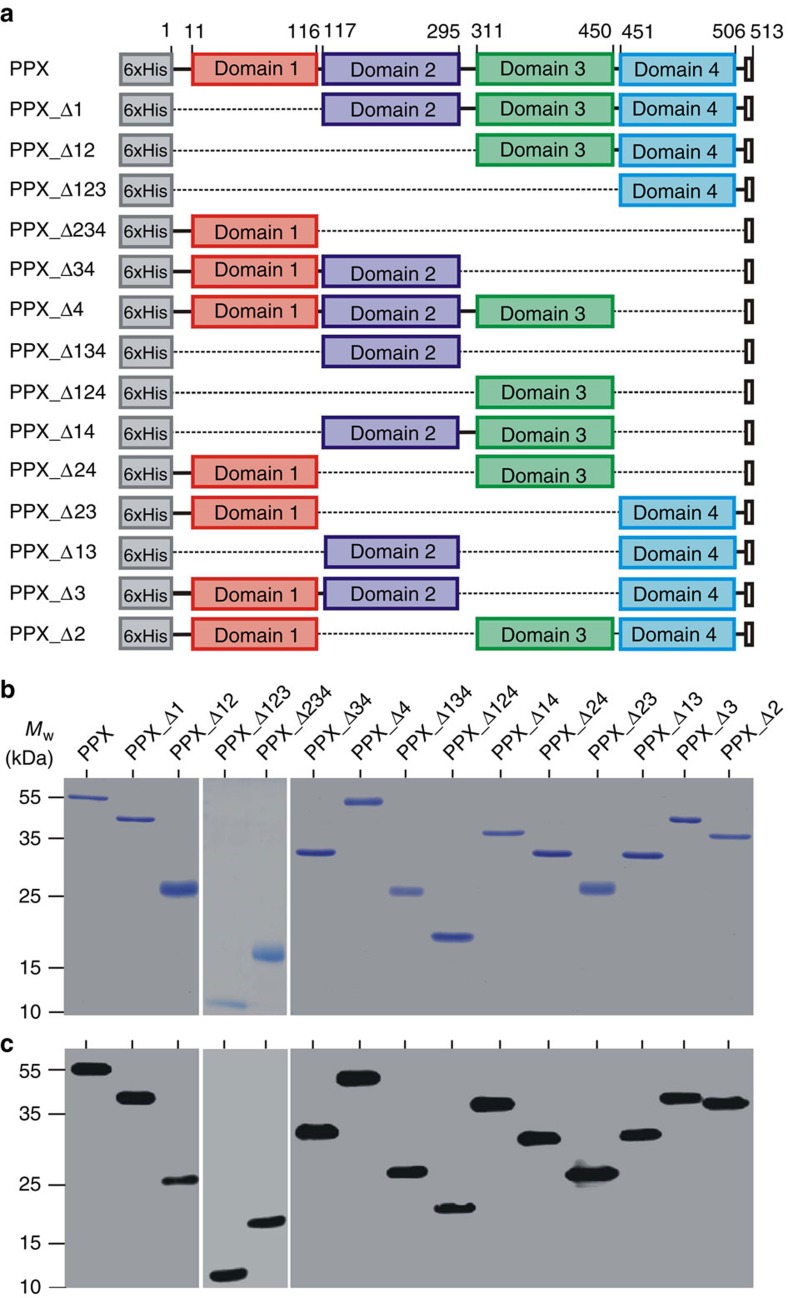
Cloning and expression of PPX mutants.(a) Scheme of full-length PPX and PPX deletion mutants lacking various domains. Dark C-terminal squares represent the stop codons, and numbers on top indicate residues. All constructs were fused to an N-terminal 6xHis-tag. Affinity purified proteins were separated by SDS–polyacrylamide gel electrophoresis and visualized by (b) Coomassie brilliant blue staining or (c) western blotting with an antibody against the 6xHis-tag. A representative photographic film of three independent experiments is shown.